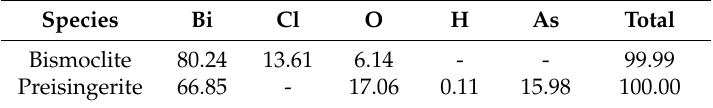
Table 4. Ideal chemical composition for bismoclite and preisingerite reported in weight %.